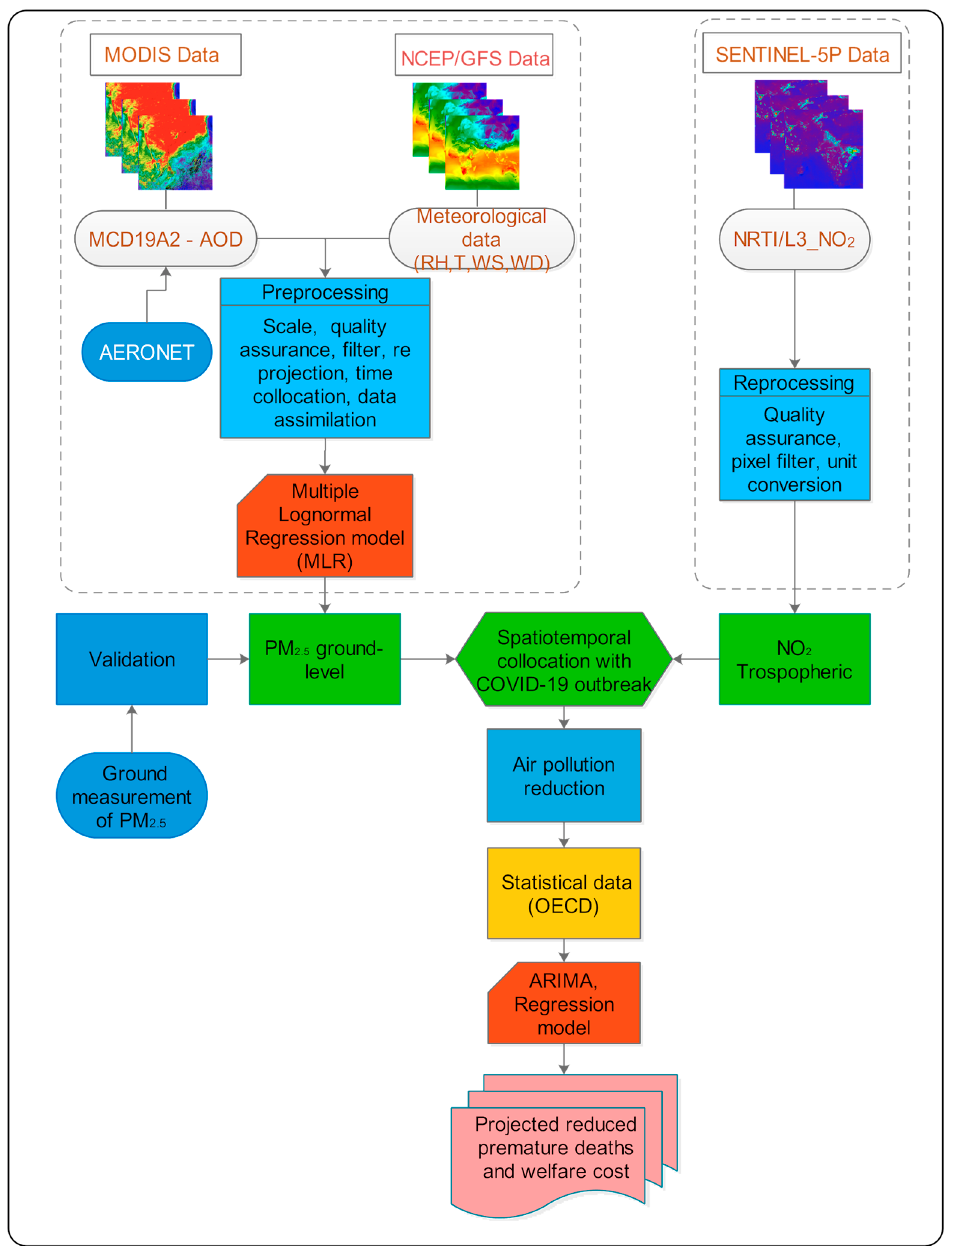
Figure 1. Flowchart of the steps taken in projecting reduced premature deaths and welfare costs associated with improved air quality in China following the implementation of COVID-19